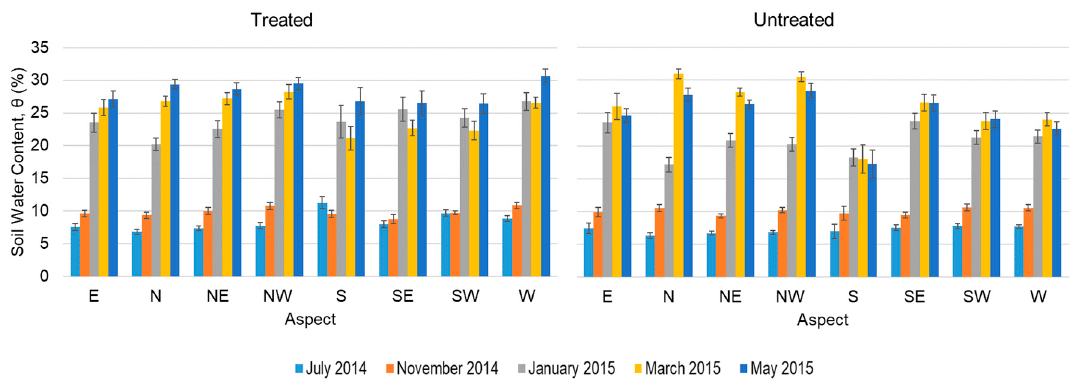
Figure 4. Distribution of mean soil water content, θ (± SE) by aspect and by measurement month